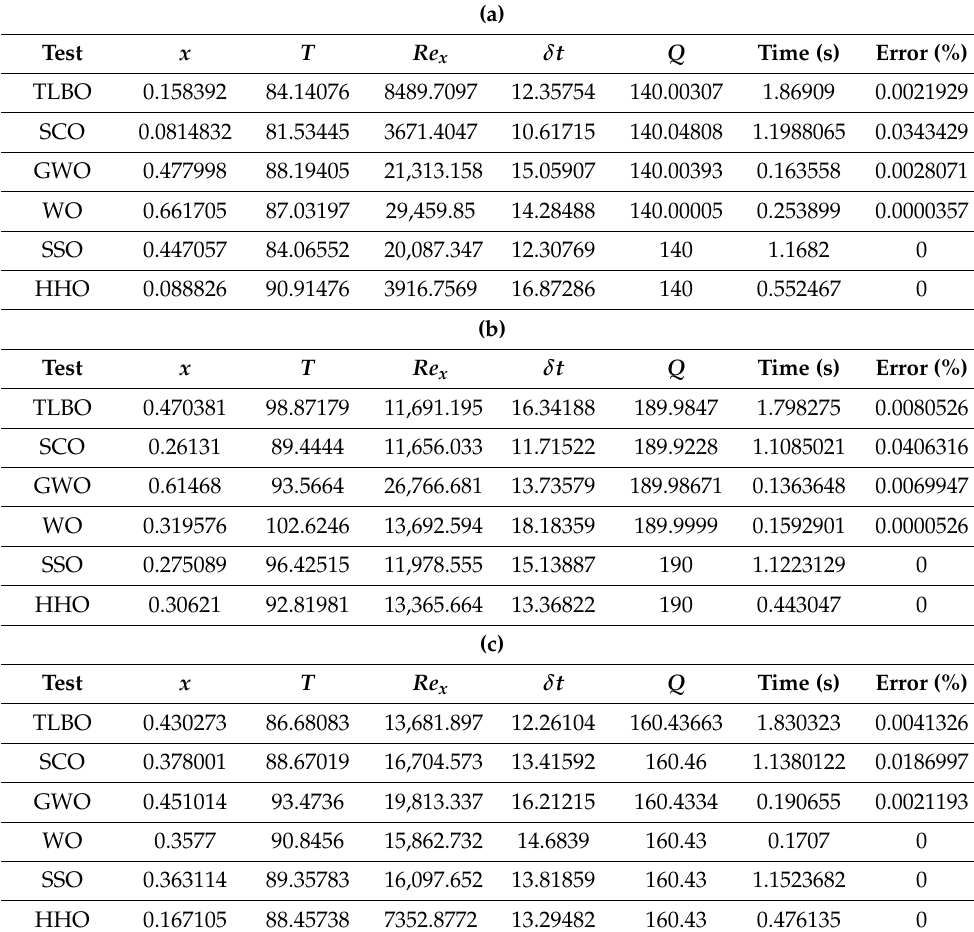
Table 3. Case 2 optimization results, ( a ) Q Minimum value, ( b ) Q Maximum value, ( c ) Q Target value (160.43